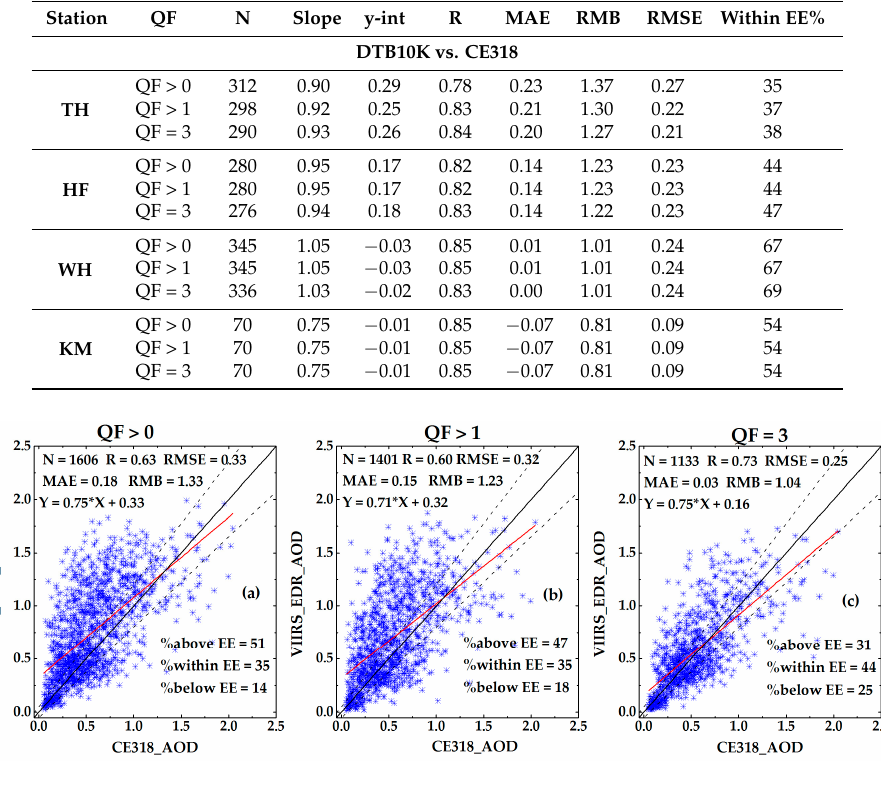
Figure 6. As in Figure 2, but comparison of the VIIRS_EDR AOD products. The DT10K AOD retrievals with QF > 0, QF > 1 and QF = 3 are presented in ( a – c ), respectively. Table 7. As in Table 3, but comparison of the VIIRS_EDR AOD products.